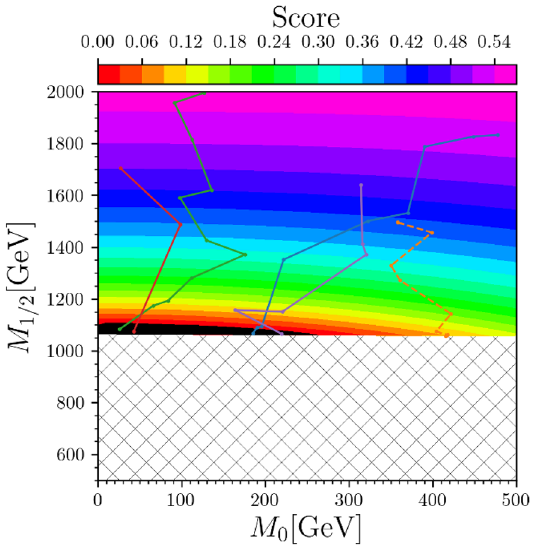
Figure 1 . The samples with seven parameters (cid:12)xed ( (cid:21) = 0 : 278, (cid:20) = (cid:0) 0 : 0577, tan (cid:12) = 17, (cid:22) = 162 GeV, A 0 = (cid:0) 1924 GeV, A (cid:21) = 2756 GeV, and A (cid:20) = 589 GeV) are projected in the M 0 versus M plane. The colored area indicate where the samples are marginal samples, and the 1 = 2 colors indicate their score. The black area indicate where the samples are perfect samples with zero score. While the grid area indicate this piece of parameter space is excluded by the basic constraints. The four solid lines indicate the marginal samples are led to become perfect samples, whereas the dashed line indicates that the marginal sample is failed to shift to a perfect